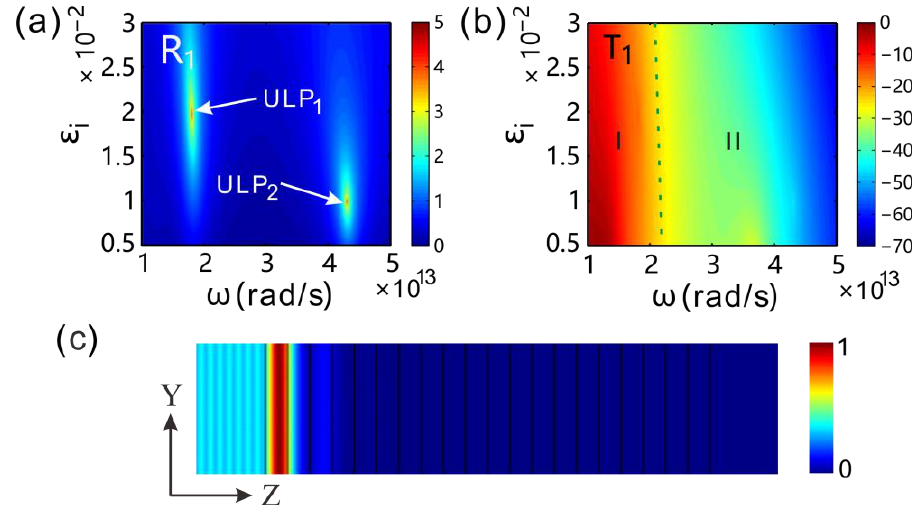
Figure 3. ( a , b ) The transmittance and reflectance varying with the permittivity and angular frequency for light incident from the left, respectively. ( c ) The electric field intensity (| E z | 2 ) distribution at the unidirectional laser point (ULP 1 ).